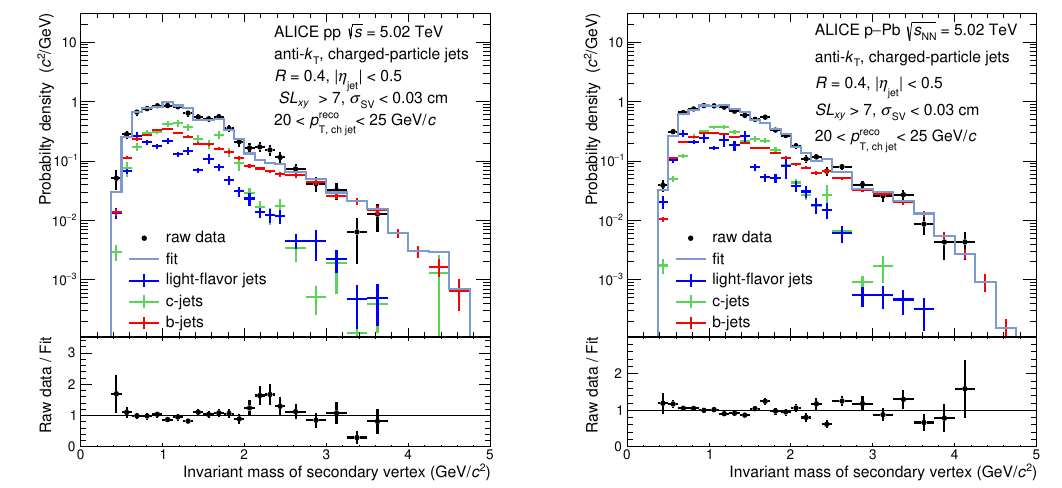
Figure 9. Invariant mass distribution of the combination of three prongs, forming the most displaced secondary vertex in jets with 20 < p reco < 30 GeV/ c , tagged with the default selection T , chjet SL xy > 7 and σ SV < 0 . 03 cm for pp (left) and p-Pb (right) collisions. The data (black points) are fitted with detector-level MC templates corresponding to beauty, charm, and light-flavor jets to assess the purity of the b-jet candidate sample. See text for further information on MC.